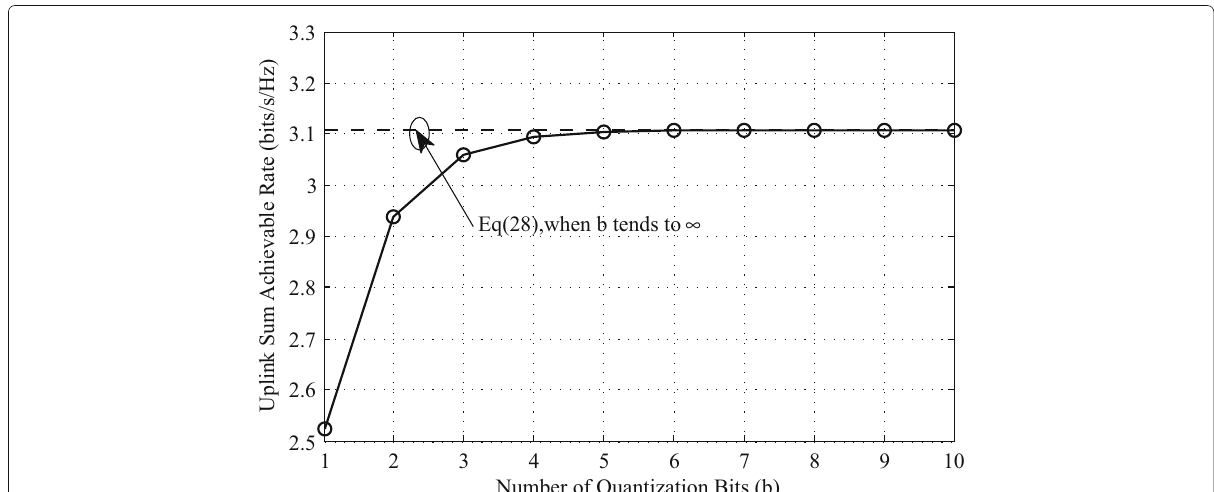
Fig. 4 Uplink sum achievable rate when b tends to be ∞ . Description of uplink sum rate for the different numbers of quantization bits b and b tends